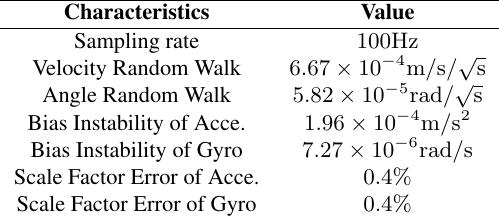
Table 1: Technical characteristics of OpenIMU330BI from